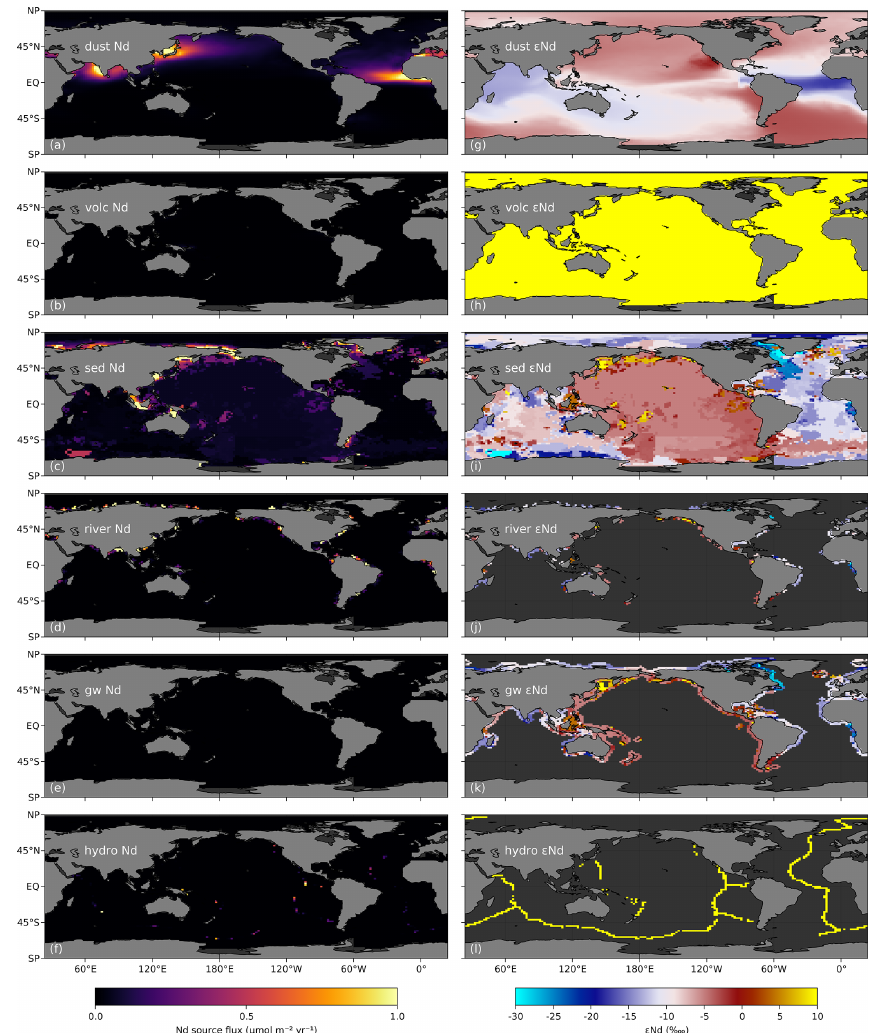
Figure 2. Vertically integrated Nd sources and corresponding vertical mean ε Nd